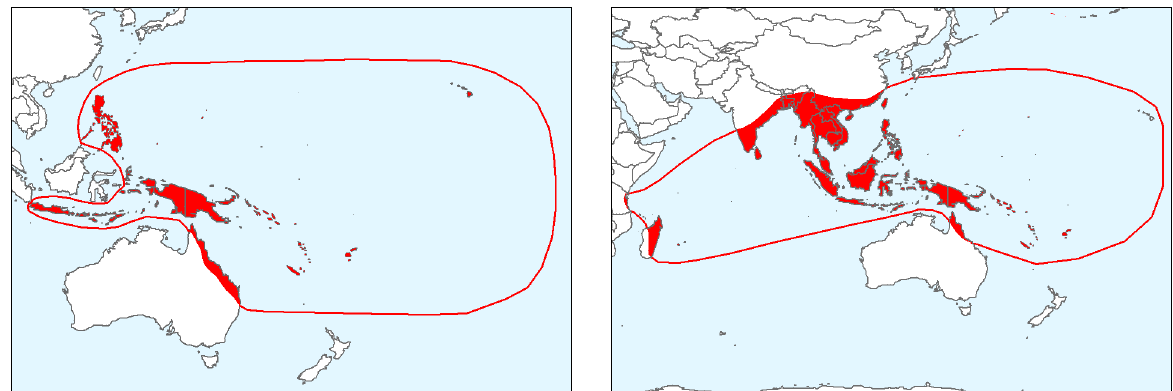
Fig. 7. Native range of Pandanus tectorius (left) and Asplenium nidus (right), involving both mainland and islands